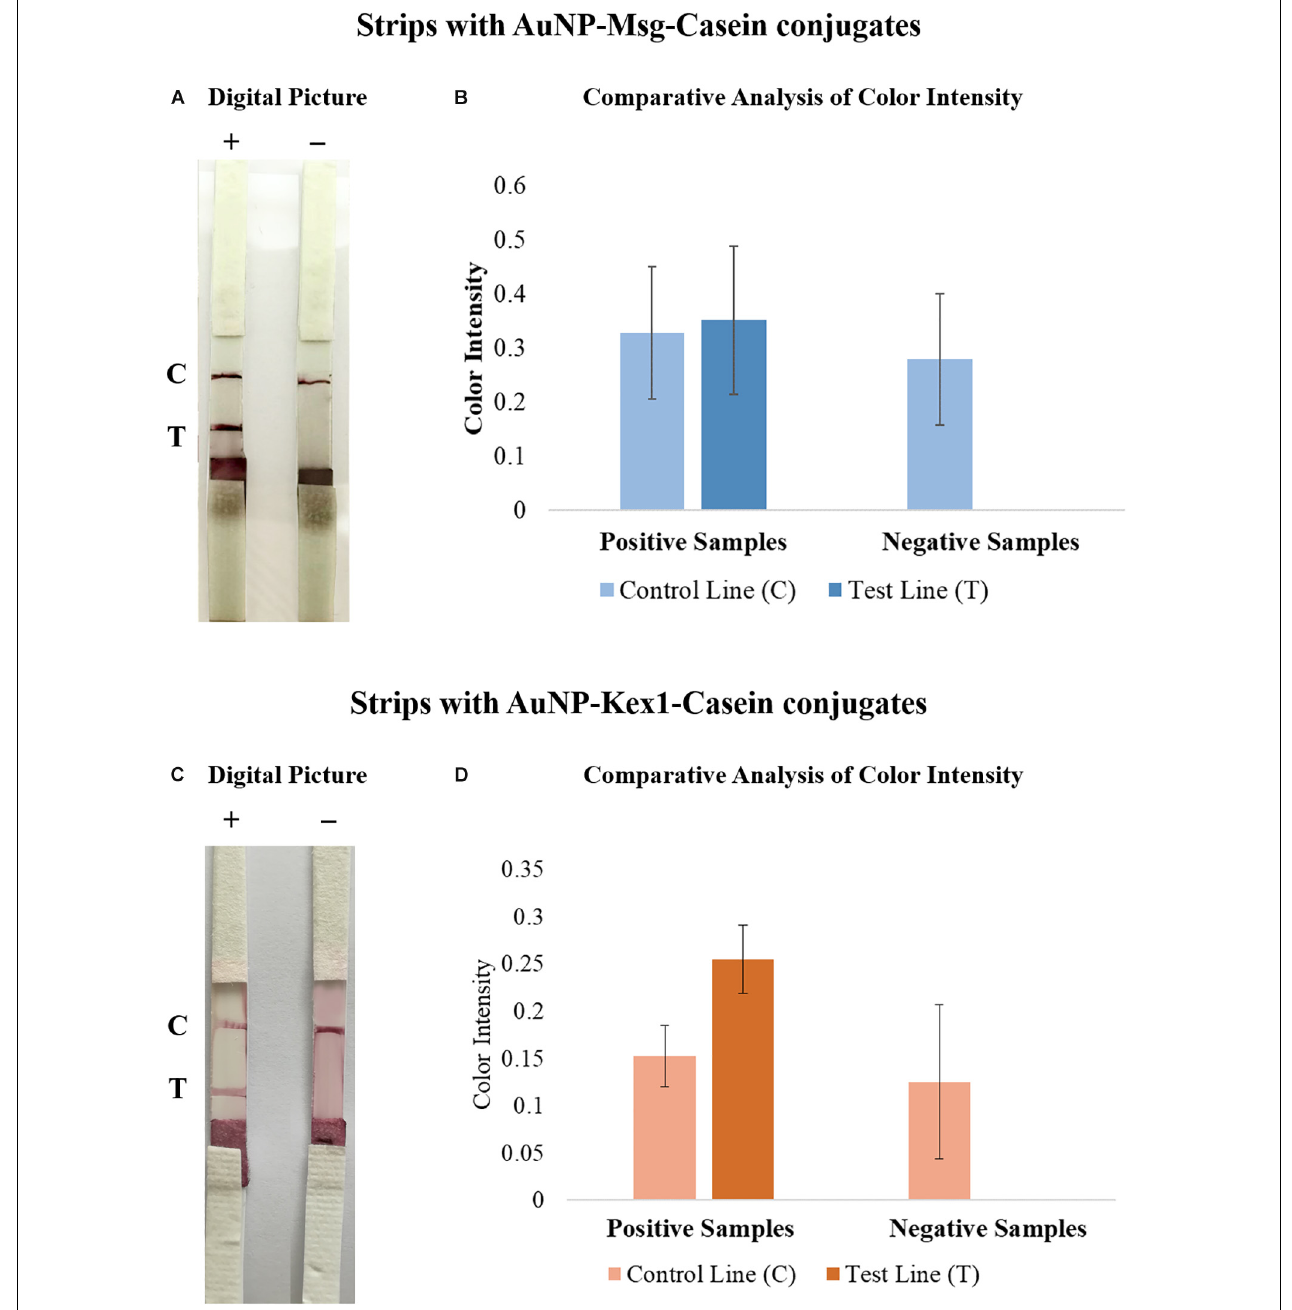
FIGURE 8 | Comparative analysis of the results from LFIA strips containing AuNP-Msg-Casein conjugates (A,B) and AuNP-Kex1-Casein conjugates (C,D) , after elution of a positive (+) or a negative (-) sample. (A,C) Digital pictures of LFIA strip results. From bottom to top, strips were composed by the sample pad, the conjugate pad, the nitrocellulose membrane with the test (T) and control (C) lines and the absorbent pad. (B,D) Quantification of color intensity of the control and test lines present in all replicates, where the intensity shown in each line corresponds to the maximum height of the Gaussian line fitted by eReuss software and the error bars represent the standard deviation